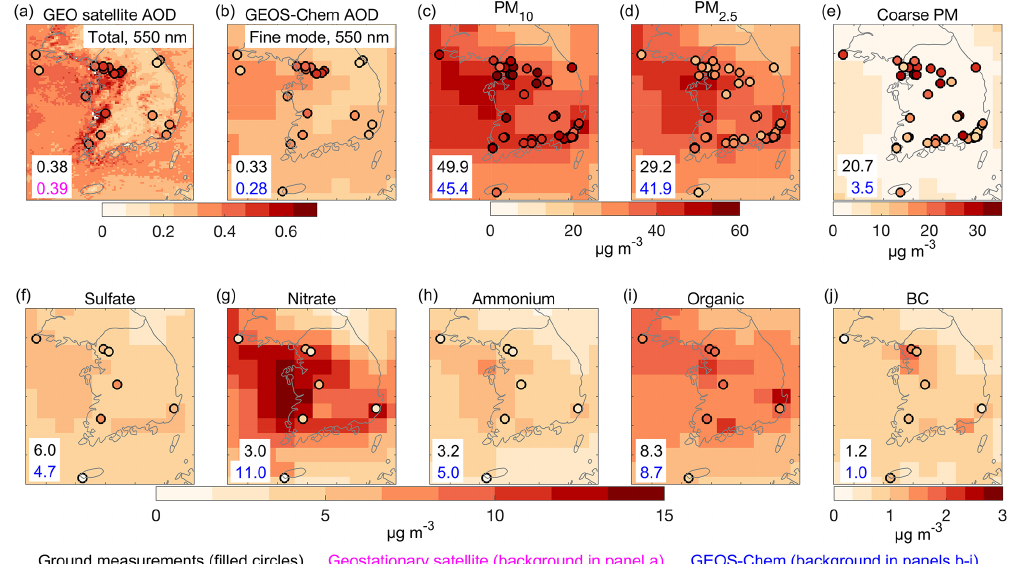
Figure 4. Spatial distributions of AOD and surface PM 10 , PM 2 . 5 , coarse PM (PM 10 minus PM 2 . 5 ), and major PM 2 . 5 components over South Korea averaged during KORUS-AQ (9 May–10 June 2016). Panel (a) shows the fused geostationary (GEO) 550nm AOD from the GOCI and AHI satellites (background) and AERONET 550nm total AOD (filled circles). Panel (b) shows GEOS-Chem 550nm AOD sampled at hourly GEO satellite AOD (GEOS-Chem clear-sky AOD; background) and AERONET 550nm fine-mode AOD (filled circles). Panel (c) shows surface PM 10 modeled by GEOS-Chem (background) and measured at ground sites (filled circles). Panels (d) – (j) are the same as panel (c) but respectively for PM 2 . 5 ; coarse PM (PM 10 minus PM 2 . 5 ); and sulfate, nitrate, ammonium, organic aerosol, and BC PM 2 . 5 components. Values inset are median values from ground-based measurements (black) and sampled from GEO satellite (magenta) and GEOS-Chem (blue). Measured PM 10 , PM 2 . 5 , and coarse PM in panels (c) – (e) are shown for a random selection of 50% of AirKorea sites to visualize spatial distribution, and inset values are for the seven supersites where PM 2 . 5 composition was measured. Median AOD values inset are sampled at or near the seven supersites to avoid biassing by the large number of sites in the Seoul metropolitan area. Modeled total PM 2 . 5 concentrations are calculated at 35% RH (Table 3). Modeled PM 10 is the sum of PM 2 . 5 , coarse dust, and coarse sea salt.